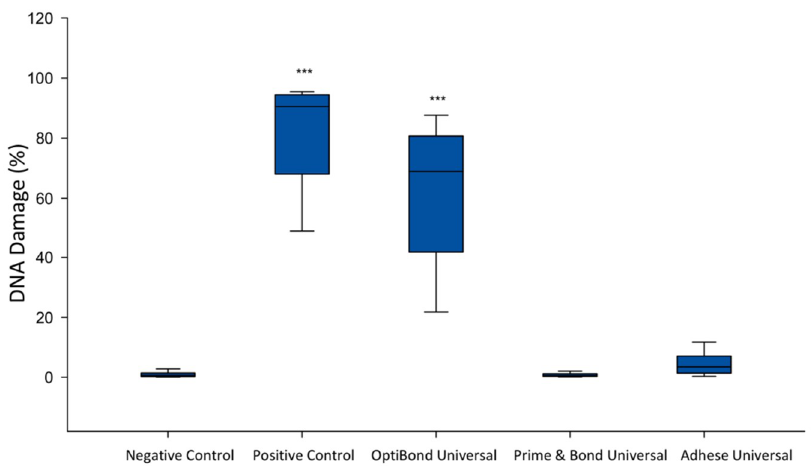
Figure 2. Genotoxicity of the investigated adhesives. *** p < 0.001 versus negative control.